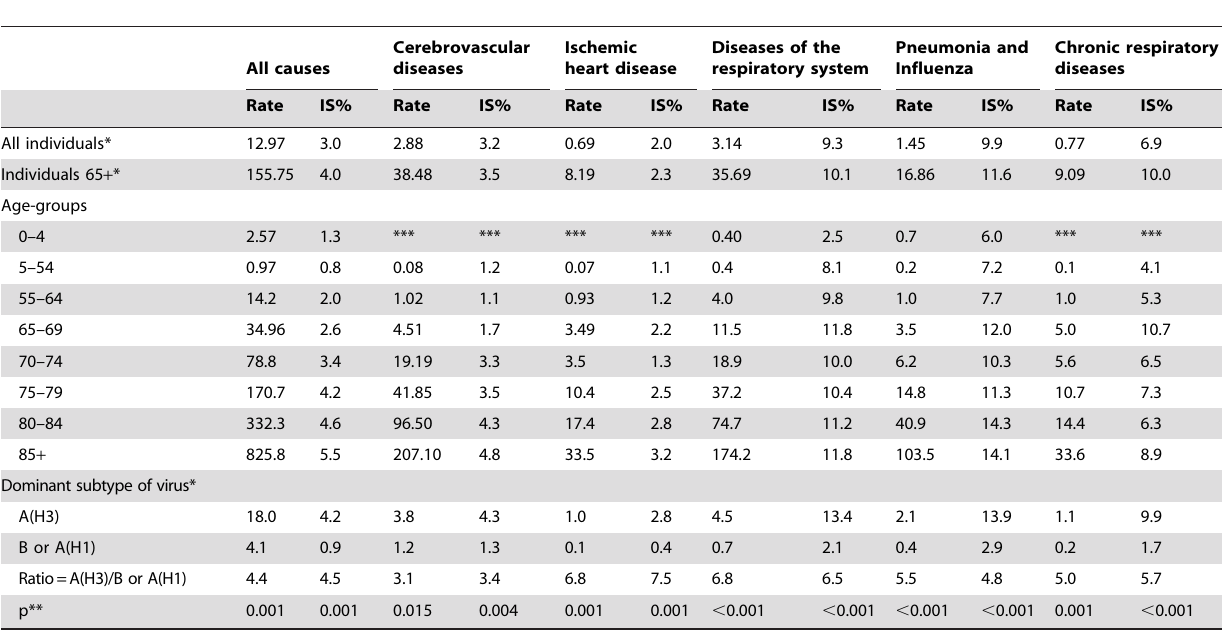
Table 2. Average rates of excess mortality associated with influenza epidemics and proportion of deaths attributable to influenza by disease outcome, age group, and dominant viral subtype, Portugal